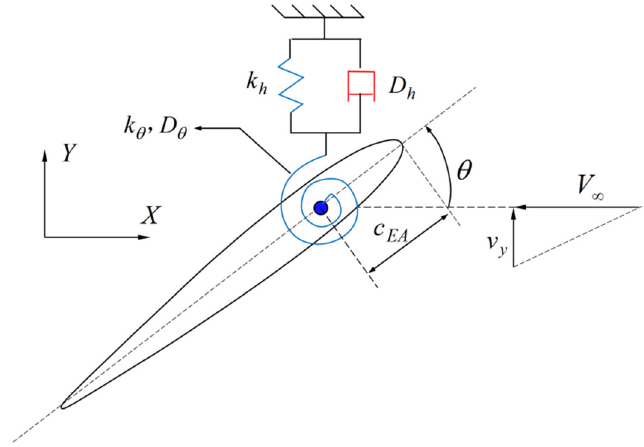
Figure 1. Simplified schematic of the symmetrical, rigid, double-elastic-constrained foil with symbolic representation of key parameters.